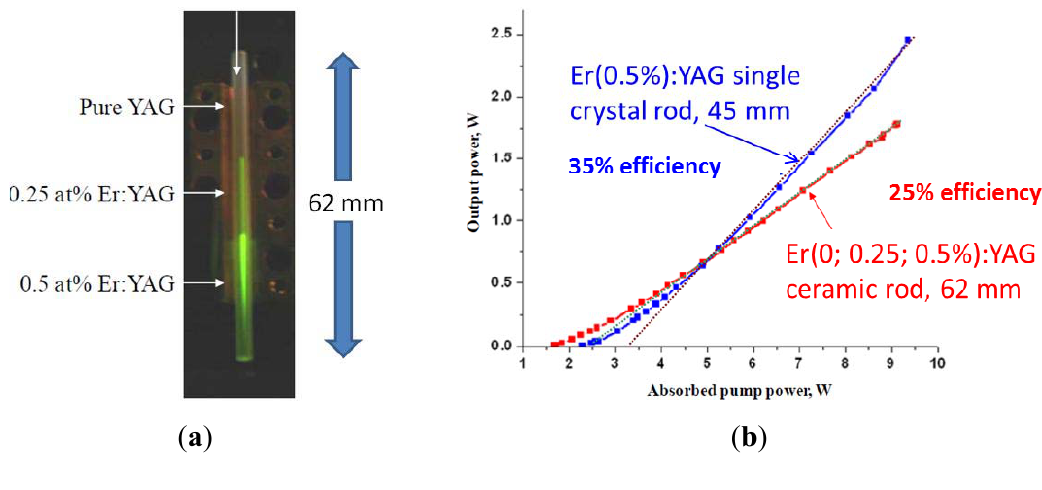
Figure 15. ( a ) Tape cast ceramic composite laser material and ( b ) laser result (Adapted from Messing